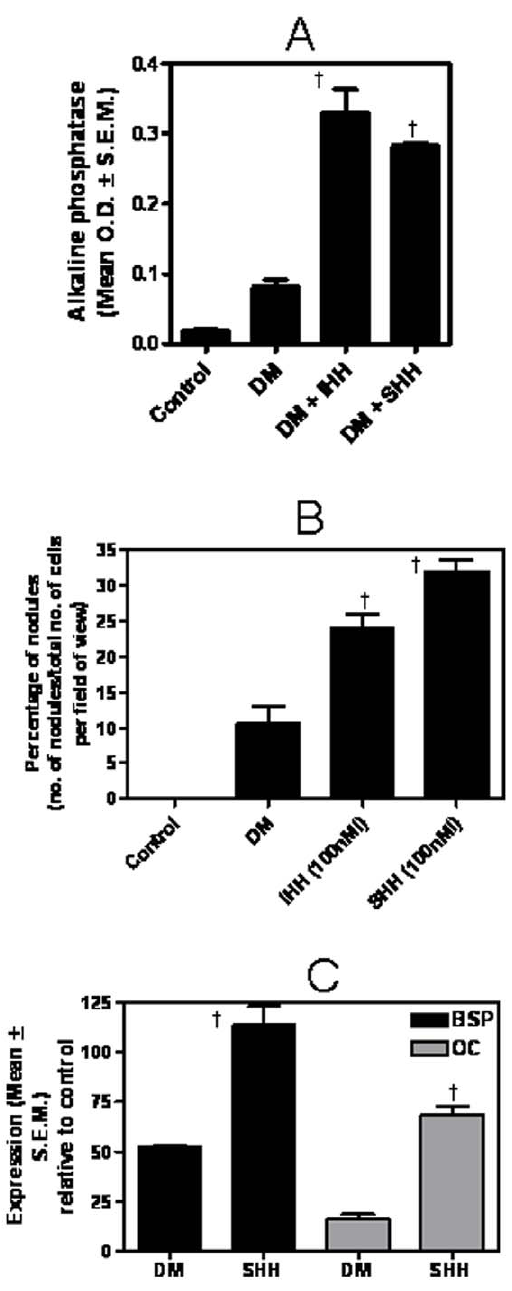
Figure 2. Activation of Hh signaling promotes differentiation and mineralization activity of osteoblasts. MC3T3 E1 Sc-14 cells were grown in differentiation medium (DM) supplemented with either with 100 nM recombinant SHH or IHH or without. Cells grown in normal growth medium were used as control. ( A ) Differentiation was assessed by alkaline phosphatase (ALP) assay. Under differentiation conditions that included recombinant IHH or SHH, the ALP activity was significantly greater ( { indicates p , 0.0001) relative to DM alone. ( B ) Relative to control (growth medium), DM induced the formation of mineralized nodules. Relative to DM the media spiked with recombi- nant IHH and SHH supports the formation of significantly greater number of mineralized nodules ( { indicates p=0.012 and 0.002, respectively). The number of nodules formed due to each treatment is represented as a percentage of the total number of cells present in each field of view. Control represents growth medium. The number of mineralized nodules in 12 independent fields per well were scored. ( C ) The expression of osteoblast differentiation marker genes, BSP (